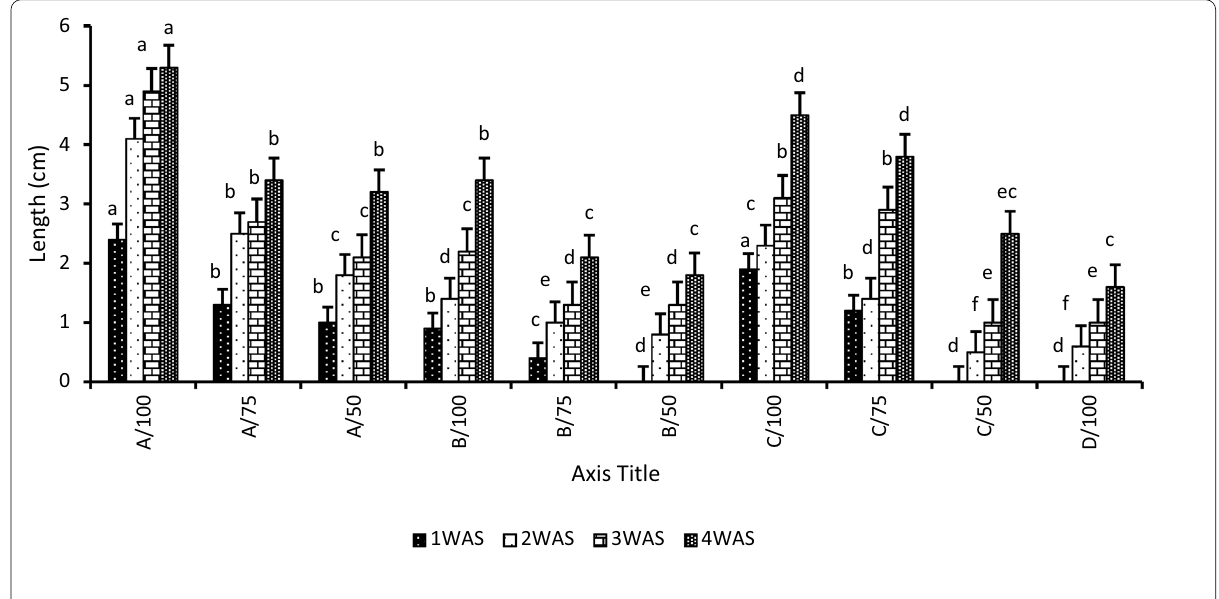
Fig. 4 Length of first leaf (WAS—weeks after sowing). Results with similar alphabets on same bars did not differ from each other ( p